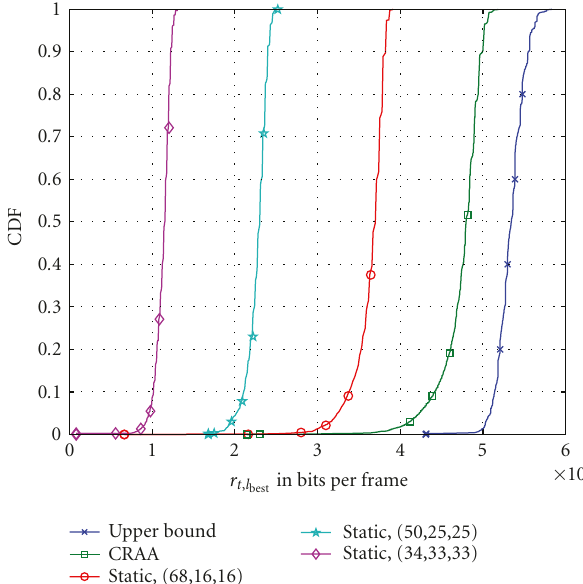
Figure 10: CDF of the data rate of the best connection assuming 21SSs in a frame and a minimum data rate of 640bits per